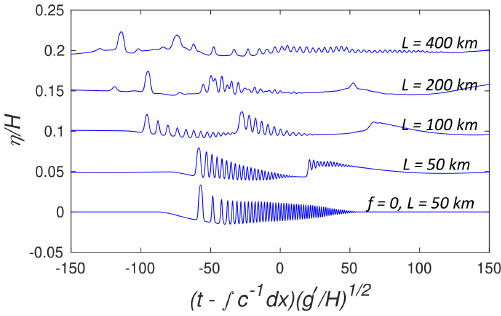
Figure 7. η/H at x/L = 1 . 2 for the parameters of Fig. 5. The bot- tom curve is the non-rotating case with L = 50km. The top four lines include rotation and have L = 50, 100, 200, and 400km from bottom to top. The curves are offset by 0 .